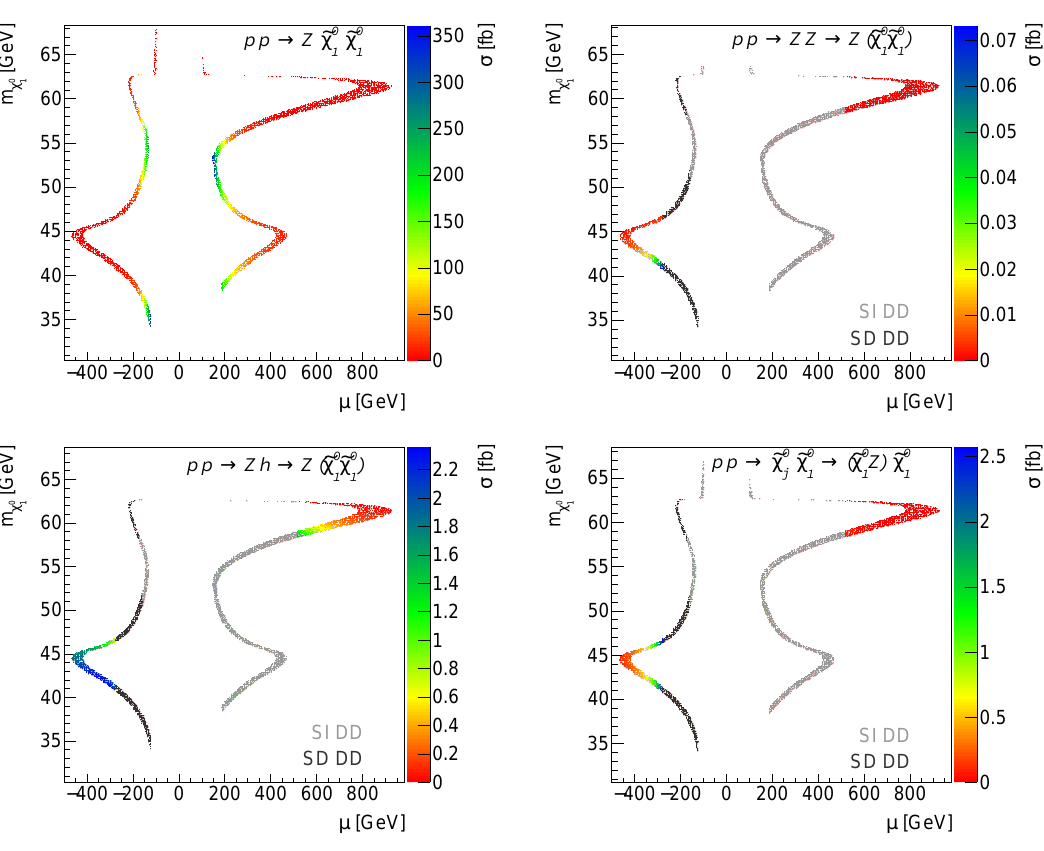
Figure 7: Mono- Z cross sections in agreement with the observed relic density (upper left). For the three LHC topologies we also show the combination with DD limits (upper right to lower right). Points excluded by spin-independent DD limits are light gray, points excluded by spin-dependent direct detection in dark